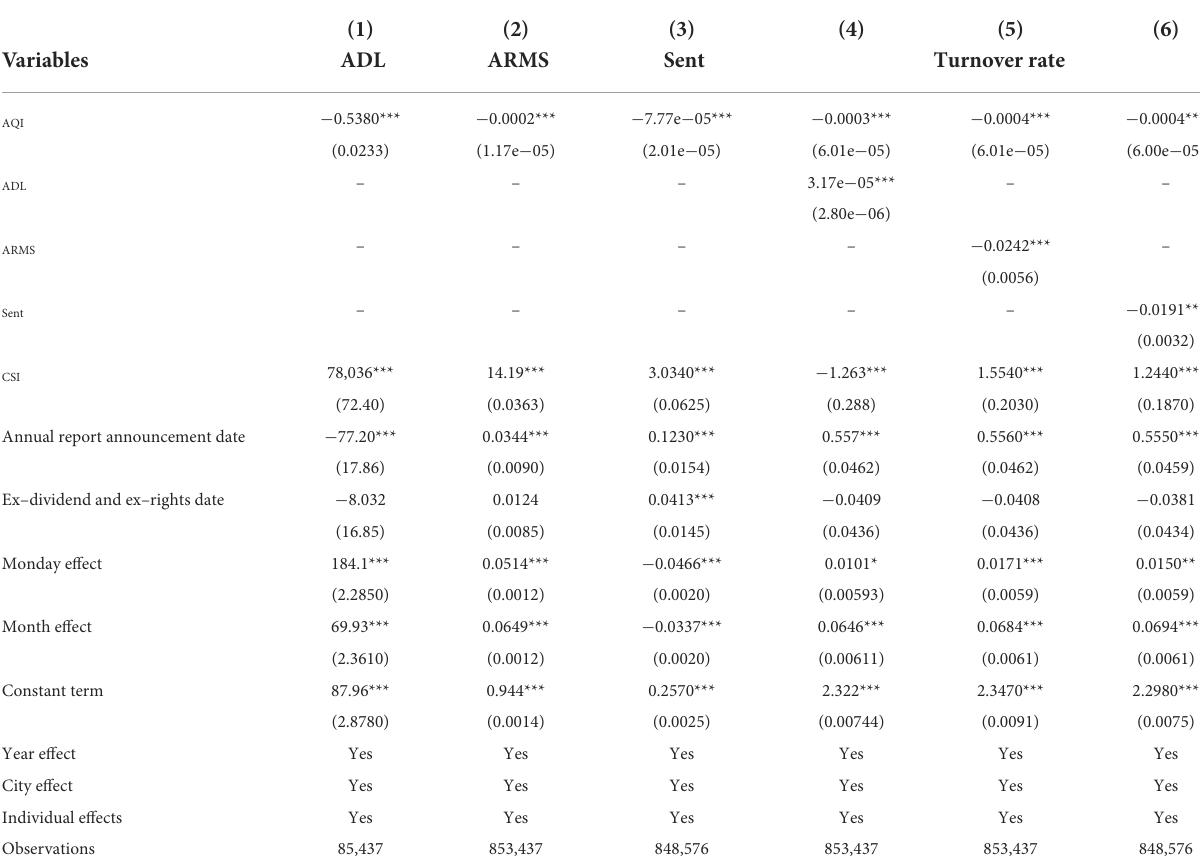
TABLE 7 Stock liquidity, investor sentiment and